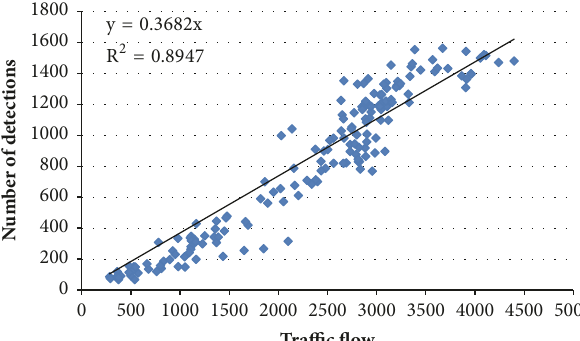
Figure 5: Relation between detected BT devices and measured traffic flow without filtering the detections at a single intersection.